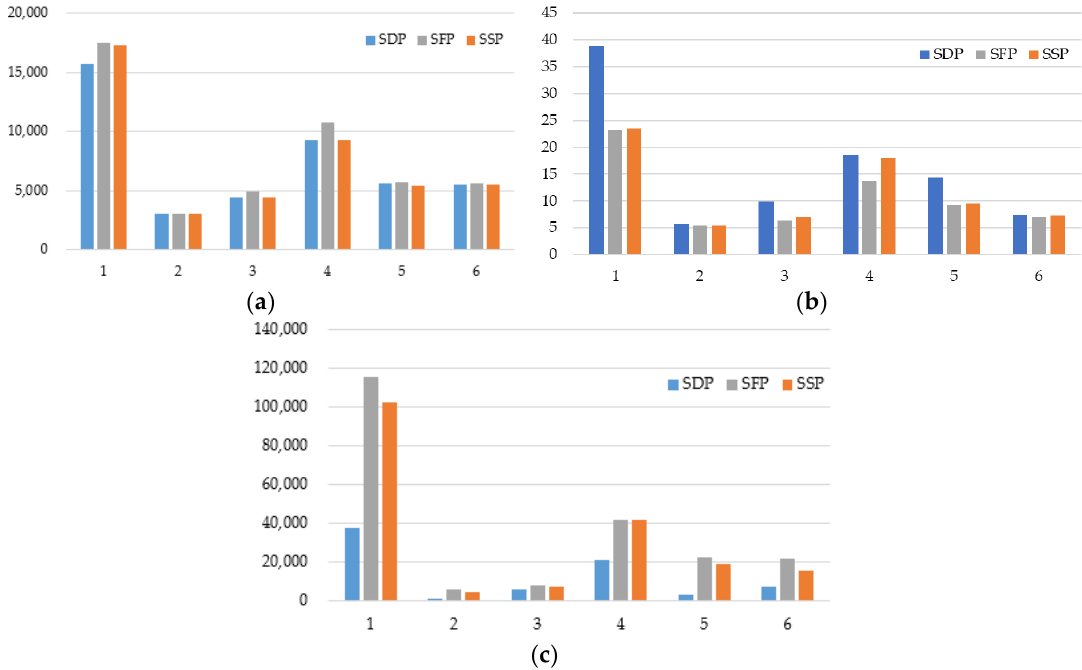
Figure 14. The comparation of key parameters of three different sorts of paths. ( a ) The total distance of the path. The unit of distance is m. ( b ) Water depth risk level of the path. ( c ) The number of expanded nodes of three sorts of cost functions.